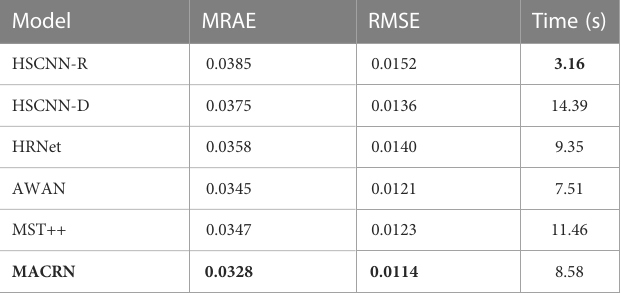
The bold numbers represent the best value.